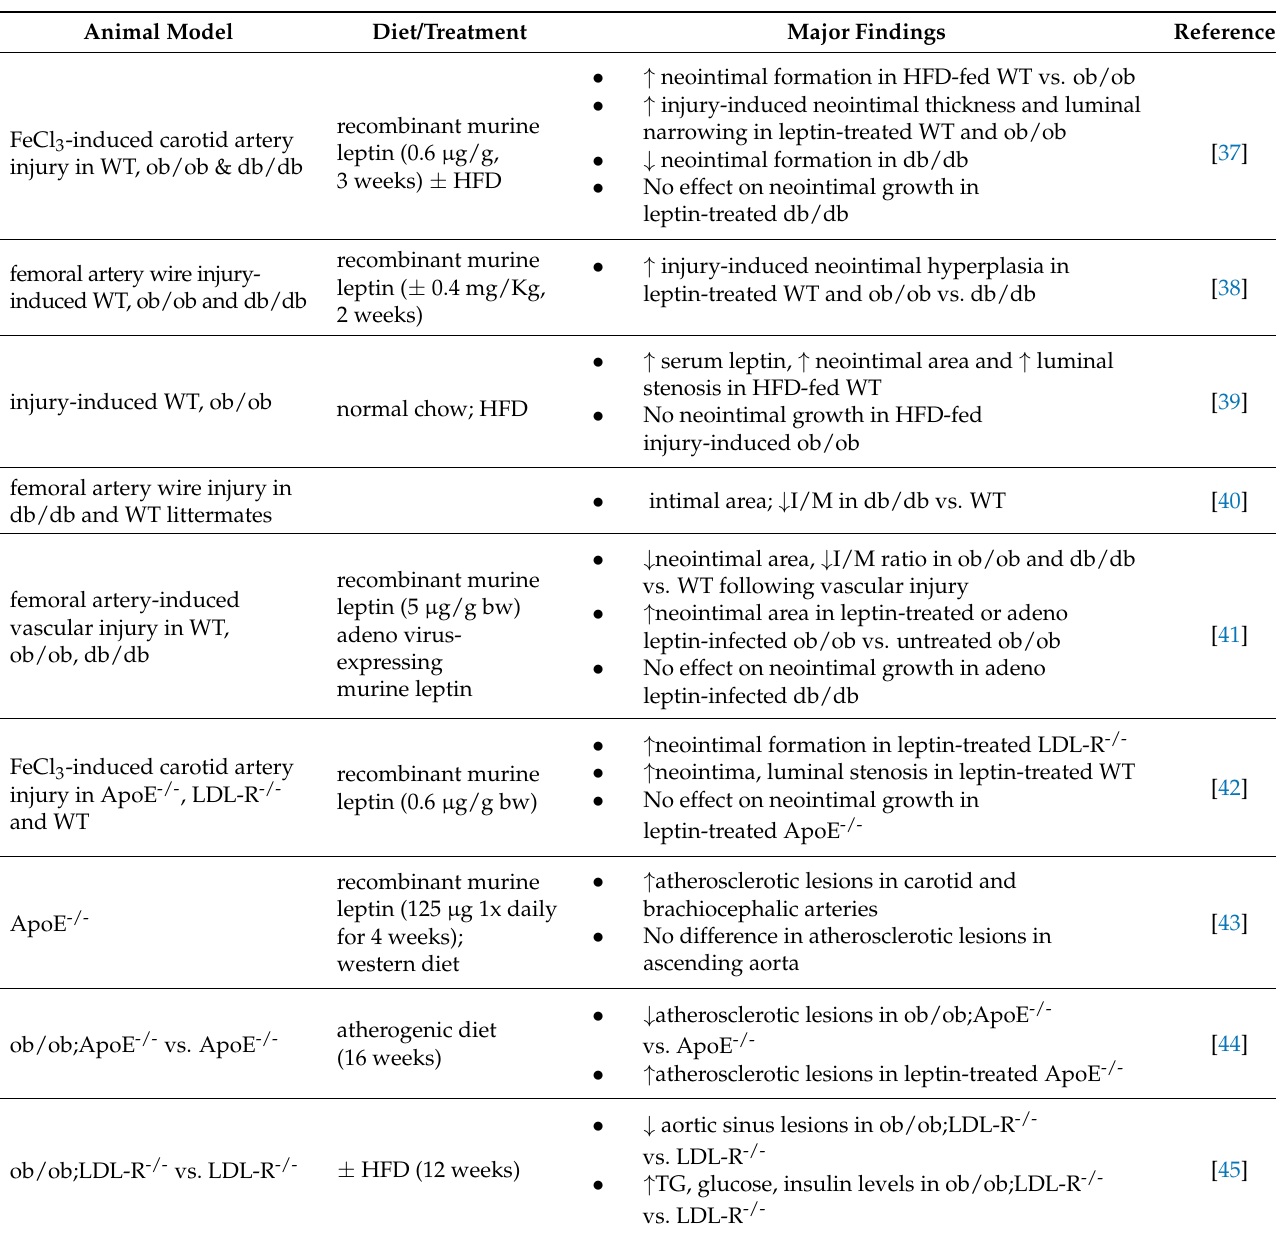
Table 2. Overview of animal studies on the role of hyperleptinemia in neointimal hyperplasia and atherosclerosis. HFD: high-fat diet; I/M: intima/media; TC: total cholesterol; TSP-1: thrombospondin-1; BCA: brachiocephalic artery. Animal Model Diet/Treatment Major